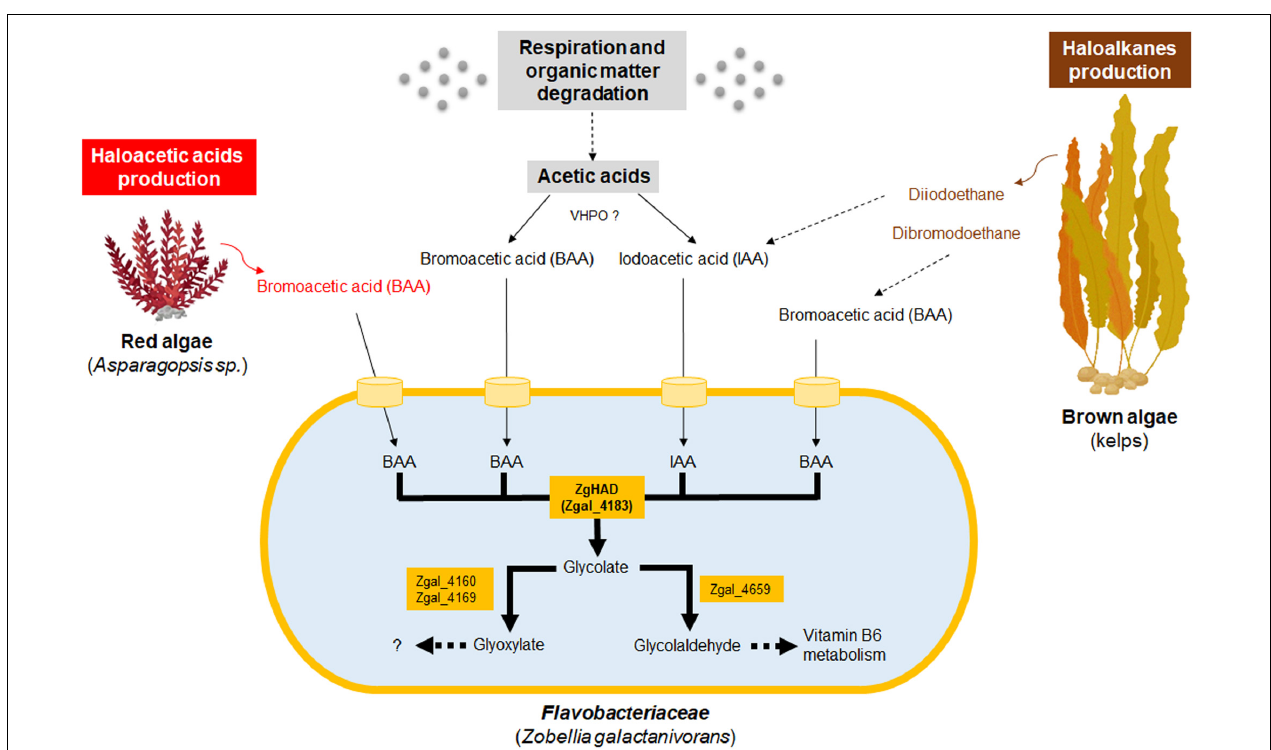
FIGURE 6 | Hypothetical scheme of production and biotransformation of haloacetates by Z. galactanivorans , in macroalgae-dominated coastal habitats. ZgHAD and Zgal_4183, L-2-Haloacid dehalogenase of Z. galactanivorans ; BAA, bromoacetic acid; IAA, iodoacetic acid; Zgal_4160, glyoxylate/hydroxypyruvate reductase; Zgal_4169, glyoxylate reductase; Zgal_4659, glycolaldehyde dehydrogenase; VHPO, vanadium-haloperoxidases. Dotted arrows refer to multistep enzymatic transformations. Oceanic biomass, red algal and brown algal transformation and productions are, respectively, colored in gray, red and brown. Specific toxic compounds produced by red and brown algae are also in red and brown fonts. Orange cylinder models the putative BAA and IAA